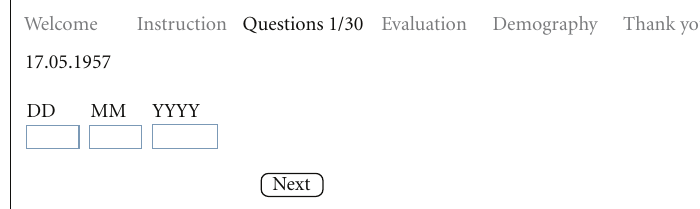
Figure 2: Example of how a task was presented to users (translated by the